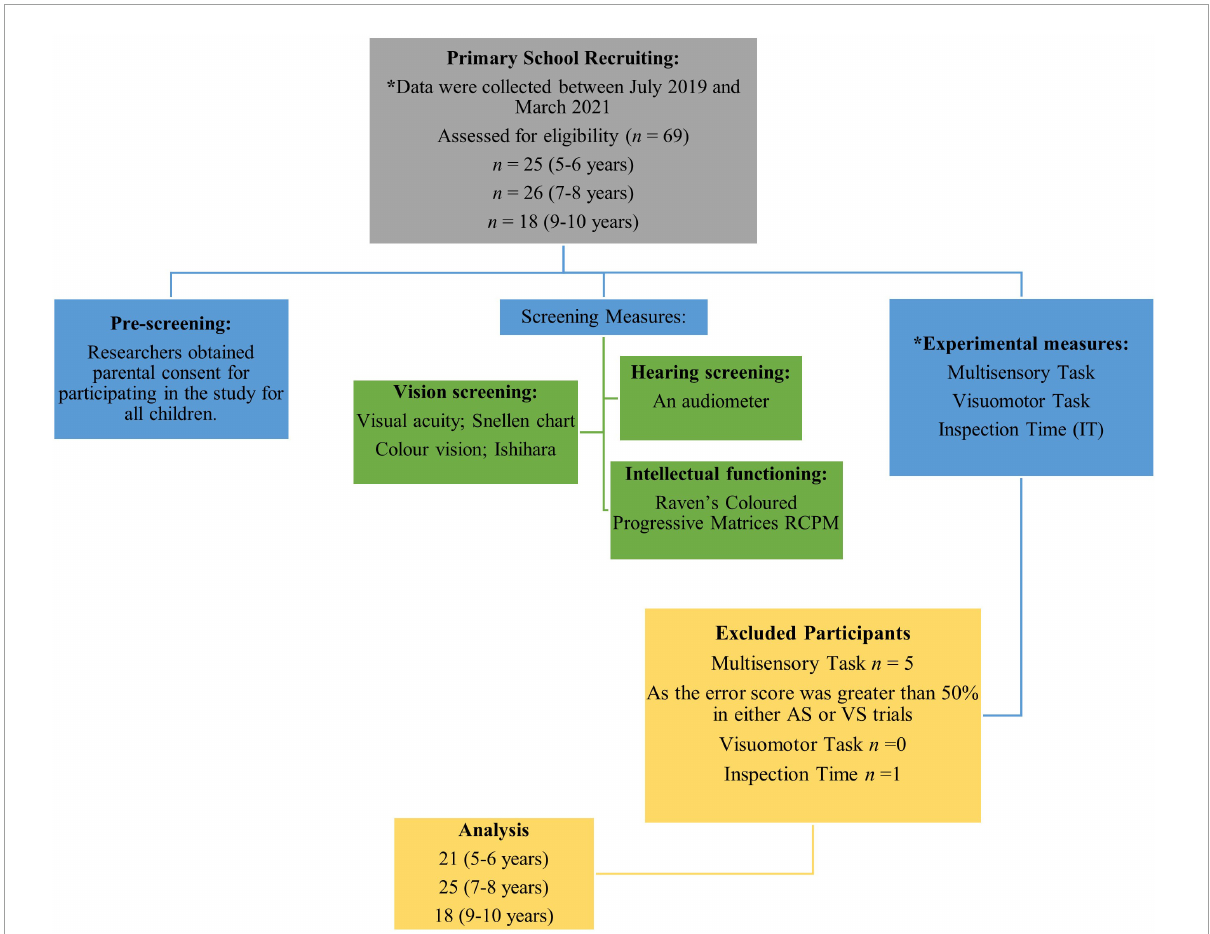
FIGURE1 Flowchart illustrating participant groups, eligibility criteria and experimental series. *There was no set task order after screening